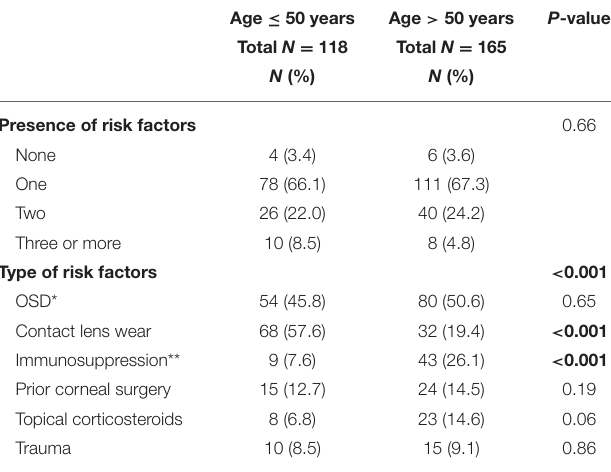
TABLE 2 | Summary of risk factors based on different age